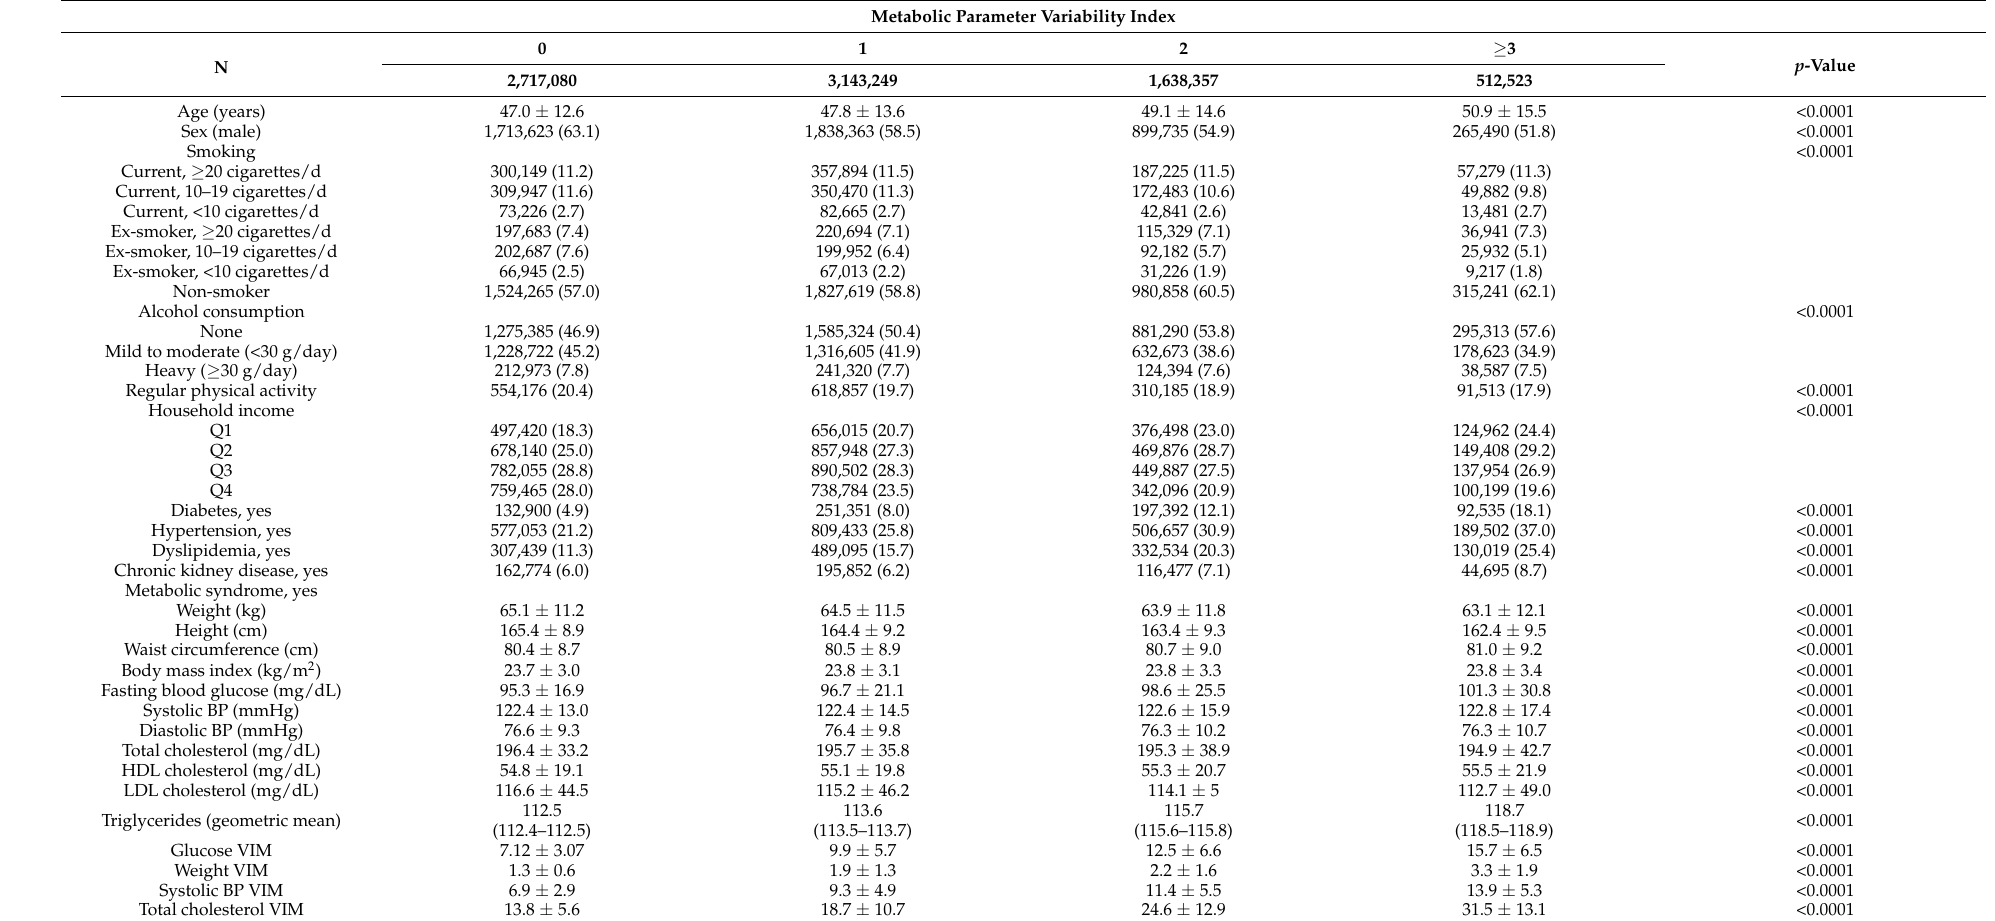
Table 1. Baseline characteristics of study population by metabolic parameter variability